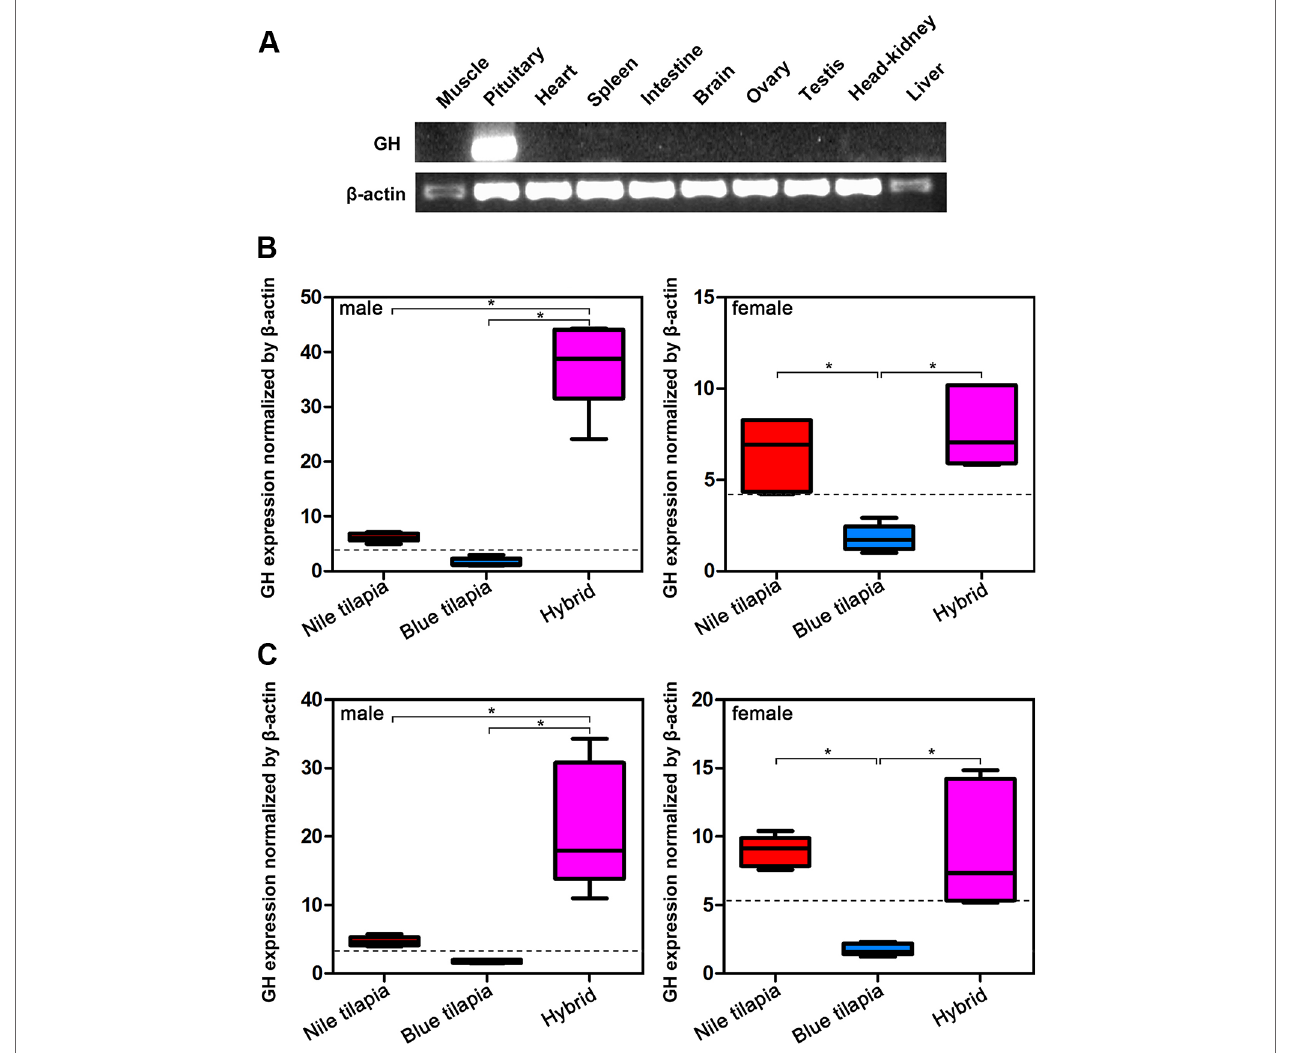
FIGURE 2 | Overall expression of GH in hybrid tilapia. (A) Tissue distribution analysis of GH mRNA expression by RT-PCR. (B) Comparison of GH mRNA expression in pituitary from 5-month-old Nile tilapia, blue tilapia, and hybrid by qPCR. (C) Comparison of GH mRNA expression in pituitary from 2-year-old Nile tilapia, blue tilapia, and hybrid by qPCR. Data are presented as the mean ± SEM (n = 5). Asterisks indicate significant differences between groups ( P < 0.05). Dashed lines indicate MPV calculated from the average value of Nile tilapia and blue